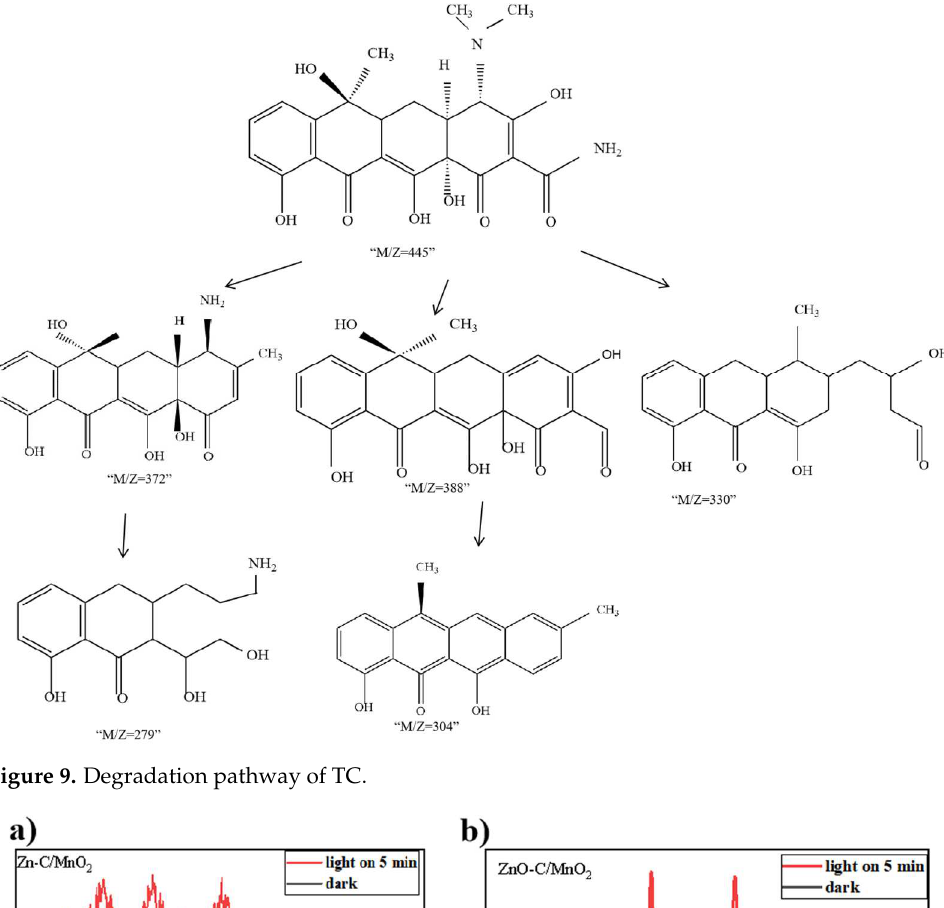
Figure 9. Degradation pathway of TC.